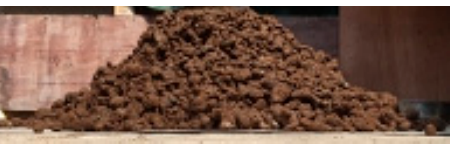
Figure 6. Experimental result.